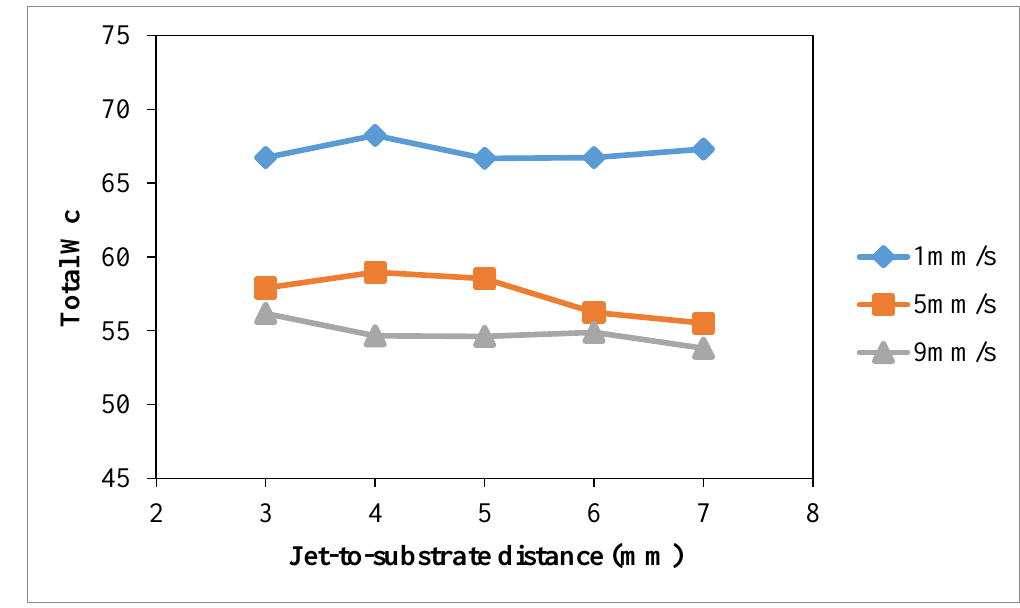
Figure 16. Effect of jet-to-substrate distance total W c (Jet-to-substrate distance: 3 mm, 4 mm, 5 mm, 7 mm and 9 mm; Jet travelling speed: 1 mm/s, 5 mm/s, 9 mm/s; Discharge power: 150 W and Oxygen flow rate: 0.4 L/min).